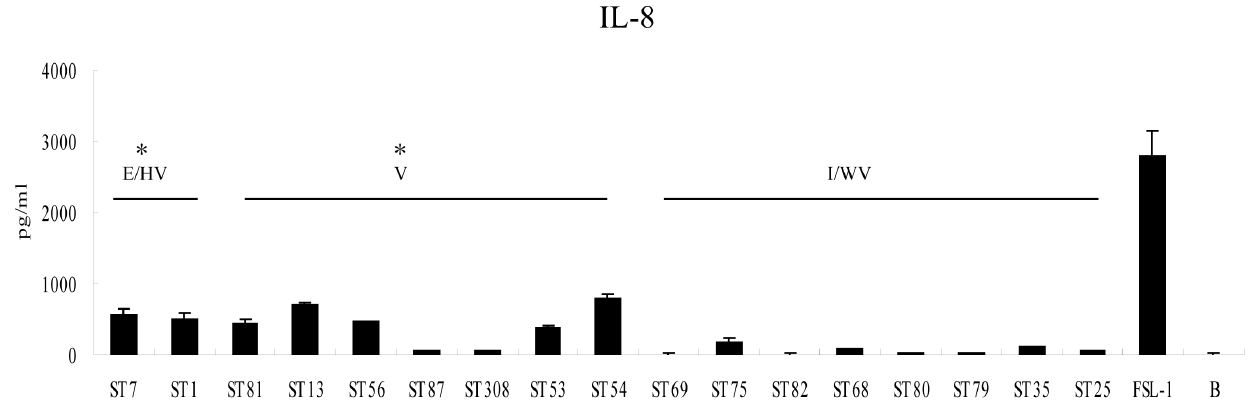
Figure 4. S.suis induced the production of IL-8 by 293-hTLR2/6 cells. All data are from three independent experiments. E/HV: epidemic or highly virulent group, V: virulent group, I/WV: intermediately or weakly virulent group, B: cell medium only. *Significant, P , 0.05, asterisks: the value of group E/HV and V compared to group I/WV.